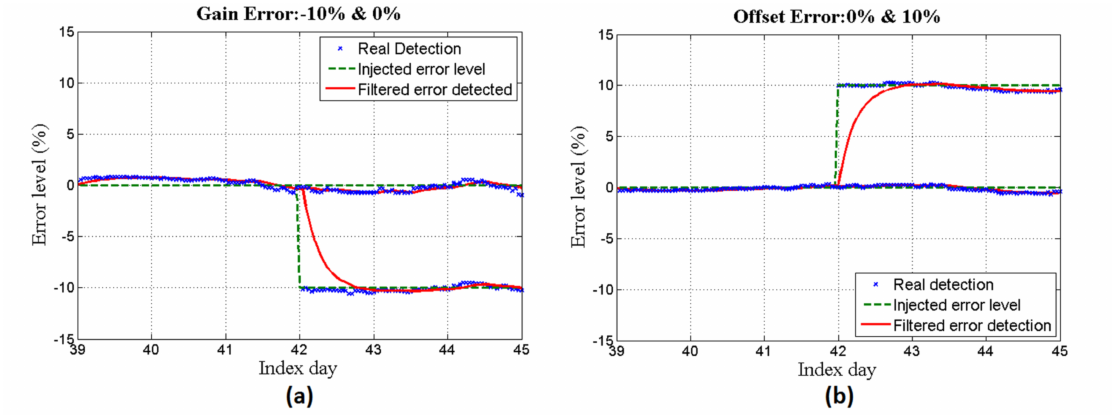
Figure 8. ( a ) 0% and − 10% gain errors and ( b ) 0% and 10% offset errors during the days after training.